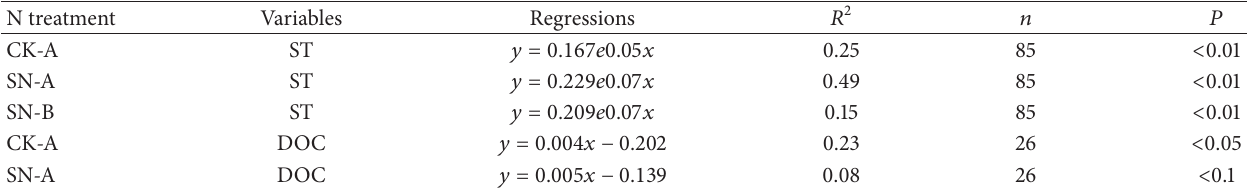
Table 4: Summary of regression analysis.